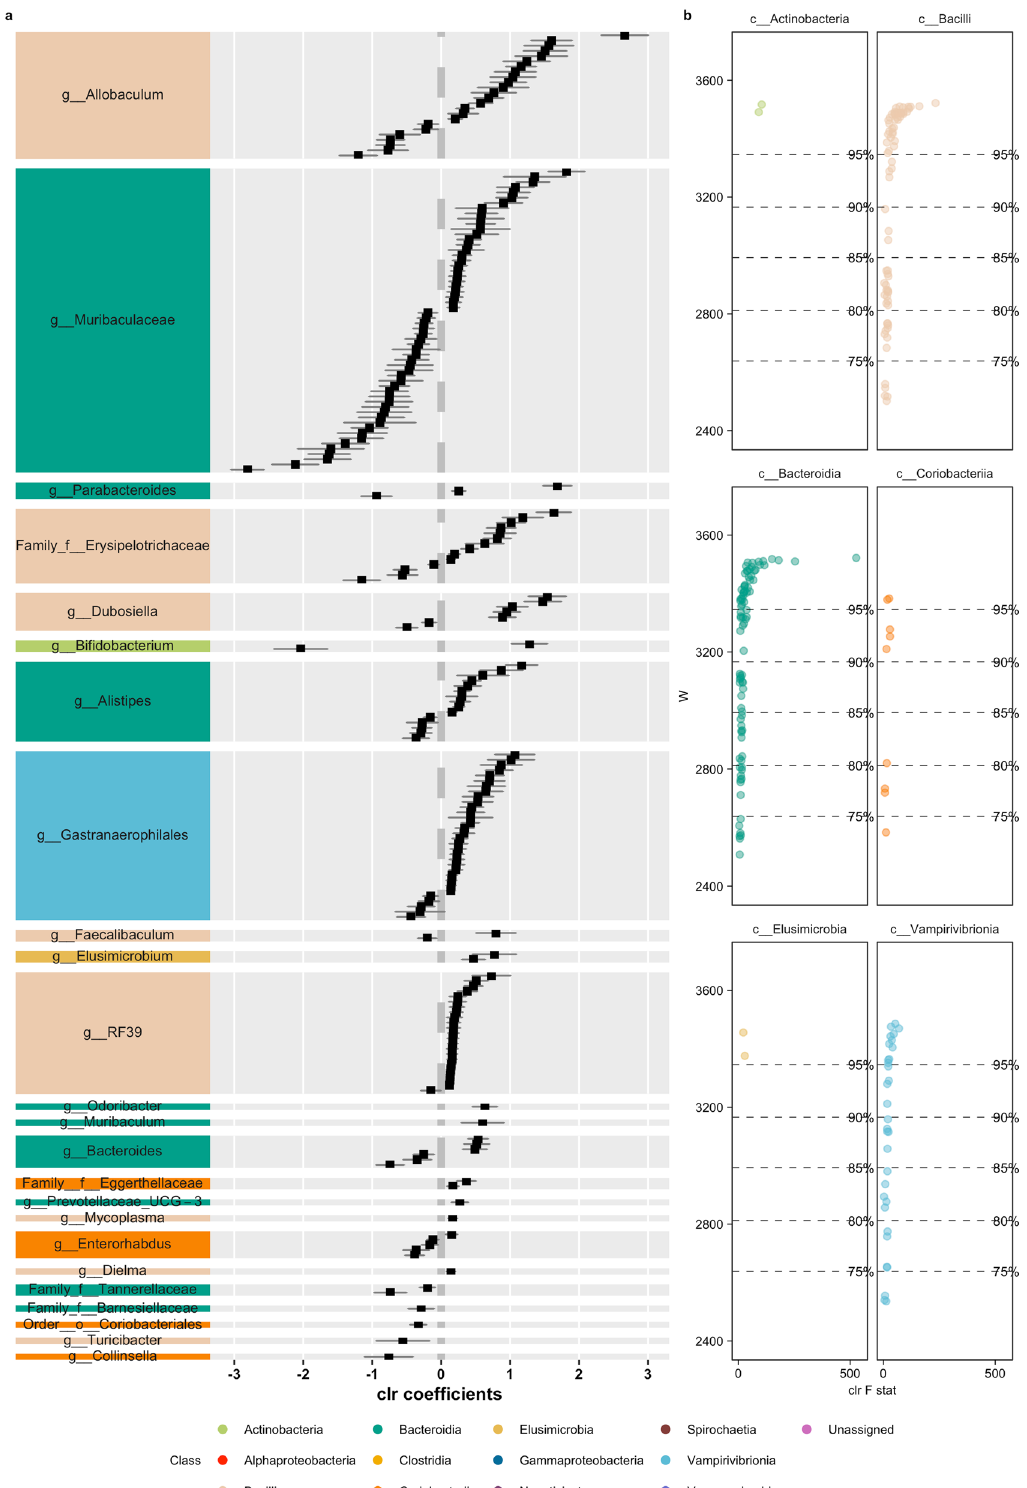
Fig. 7 First half of differentially abundant ASVs (using ANCOM) in pairwise comparisons with landscape groupings based on similar responses in beta diversity to landscape modifications (Fig. 4) in P. semispinosus comparing landscape C represent the different bacterial classes. a Differential abundant ASVs according to the taxonomical assignment; b Volcano plot of differential abundant ASVs, depicting the F statistics and